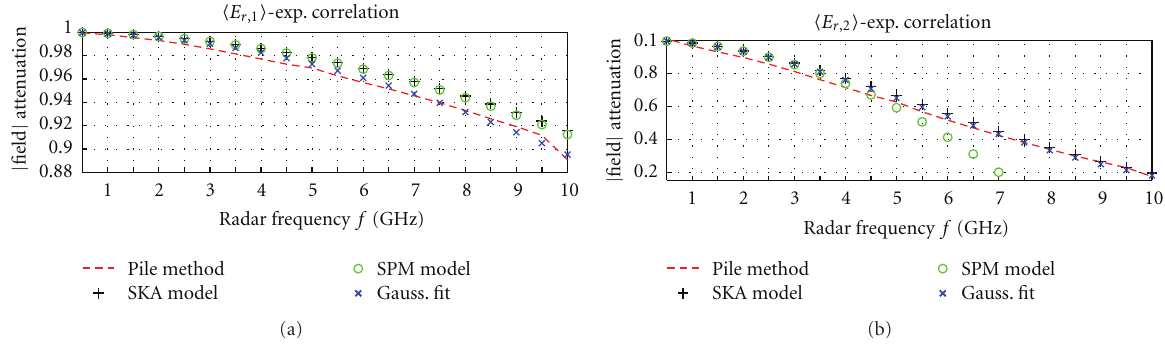
Figure 5: The Same simulation parameters as in Figure 4 (with L c A = 6 . 4mm and L c B = 15 . 0 mm), but for exponential correlation surfaces.